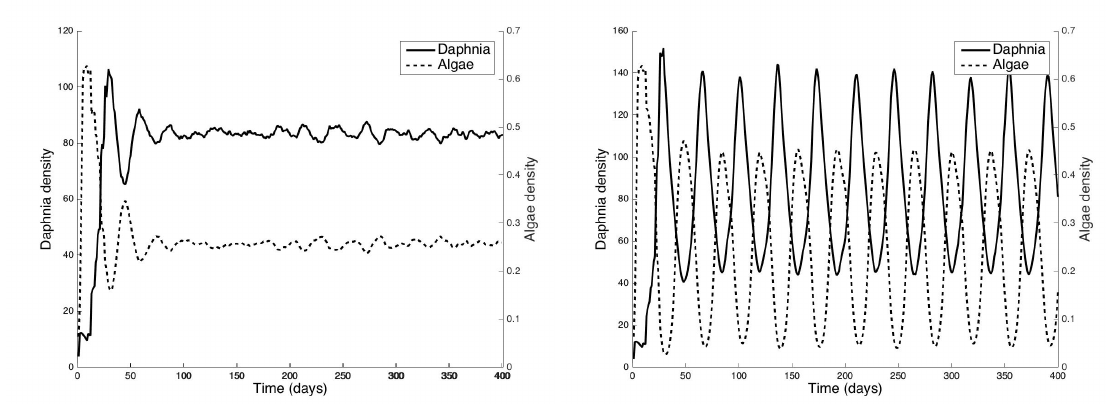
Figure 5. Simulations of the coupled daphnia and green algae dynamics model resulting in steady state behavior ( Left , c = 0.01) and sustained oscillations ( Right , c =